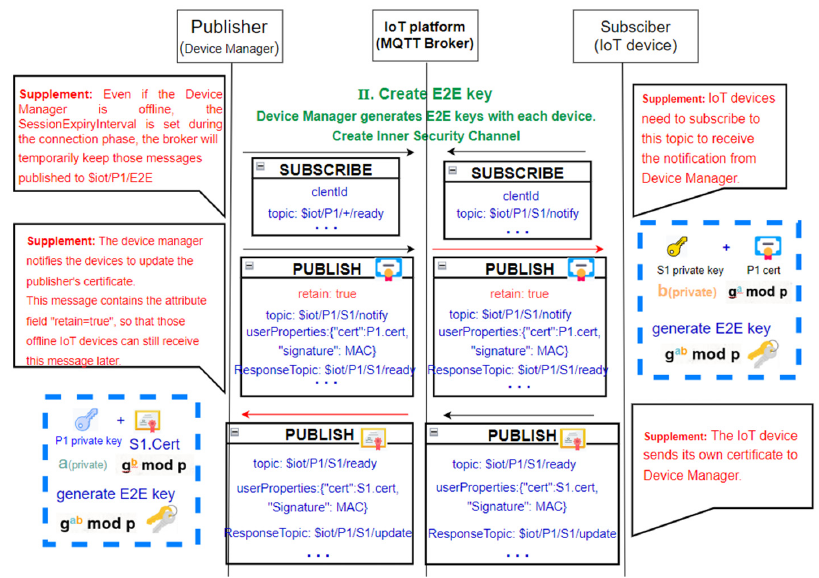
Figure 6. The message interactions during the End2End channel building.